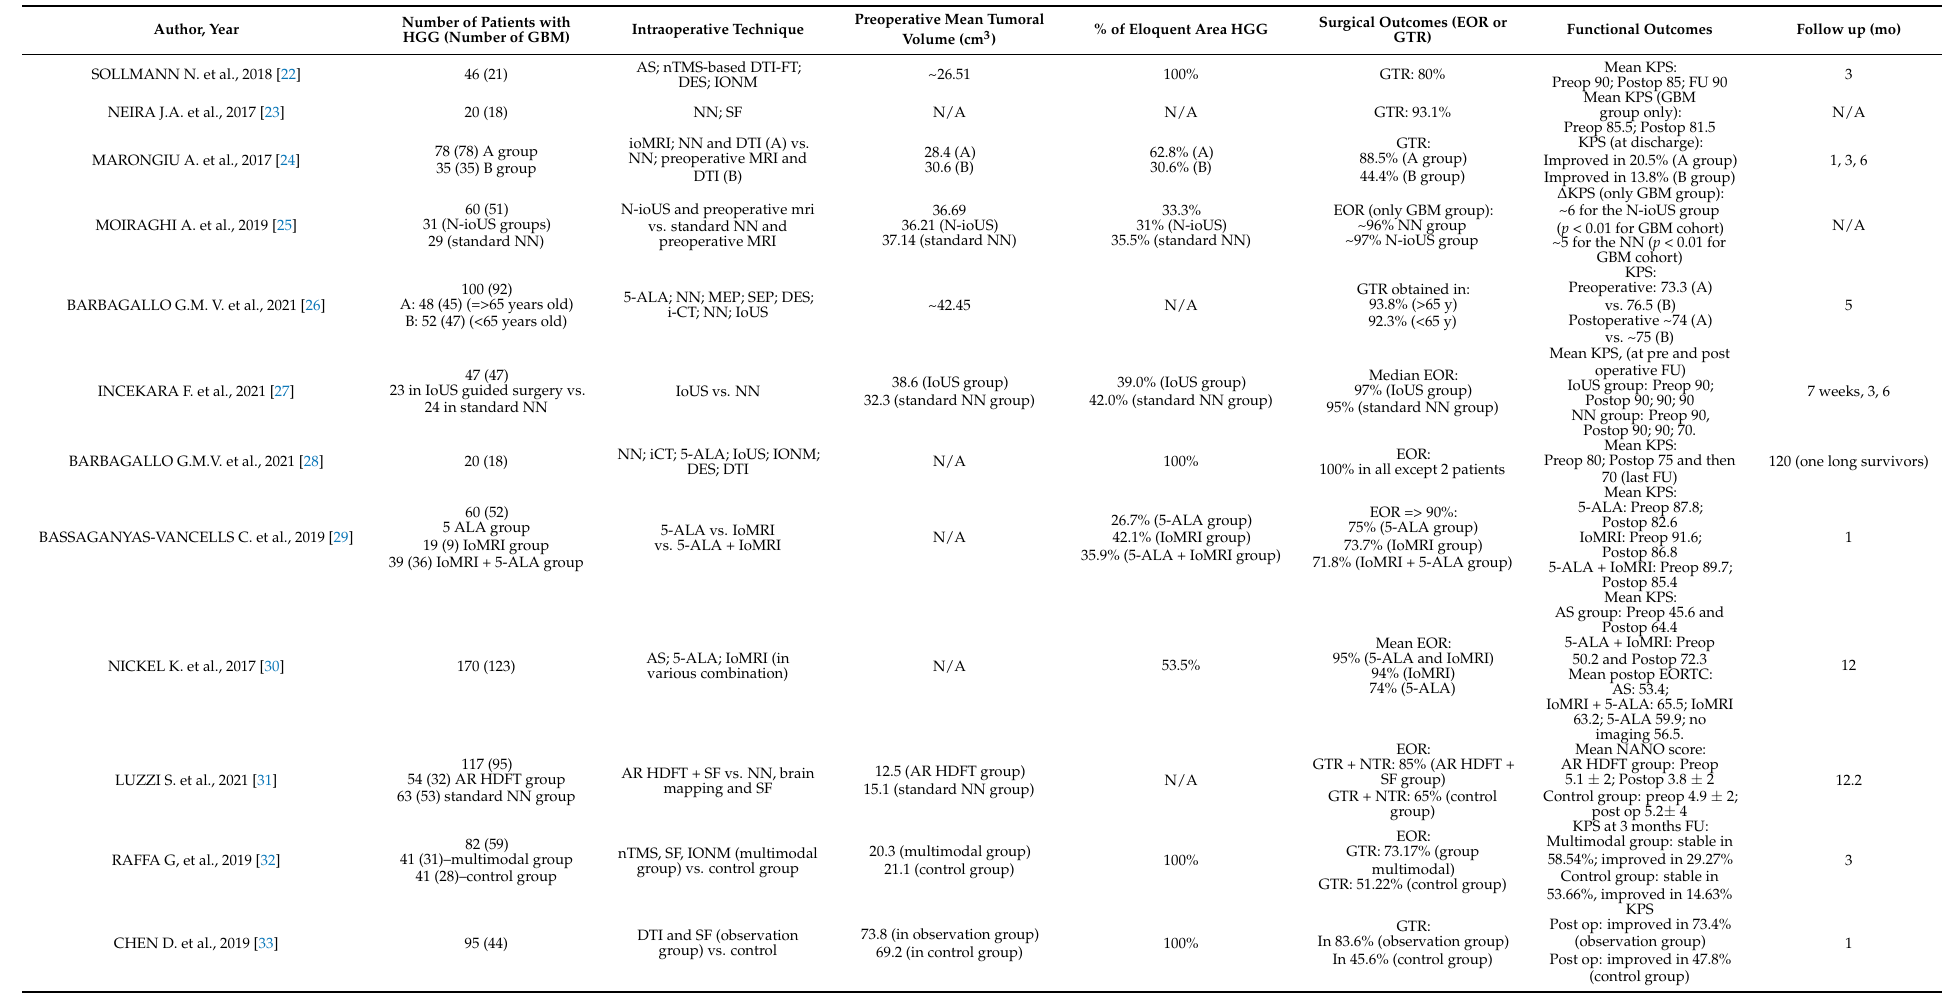
Table 2. Intraoperative technique, surgical, and functional outcomes included in the